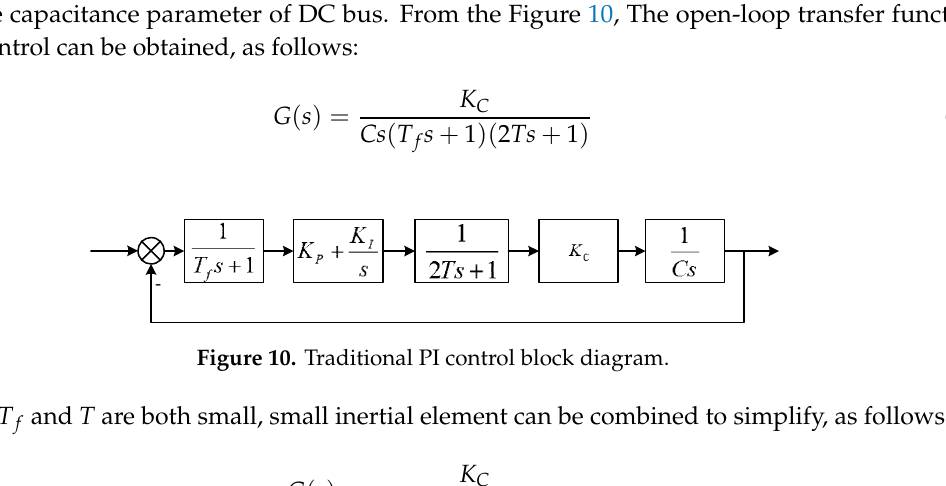
Figure 9. FLS-LESO structure.